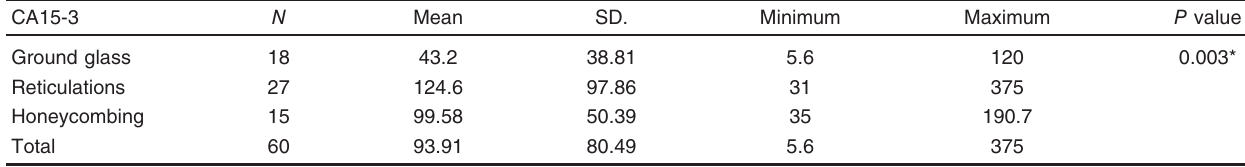
Table 4 Association between computed tomography findings and carbohydrate antigen 15-3 in the three groups CA15-3